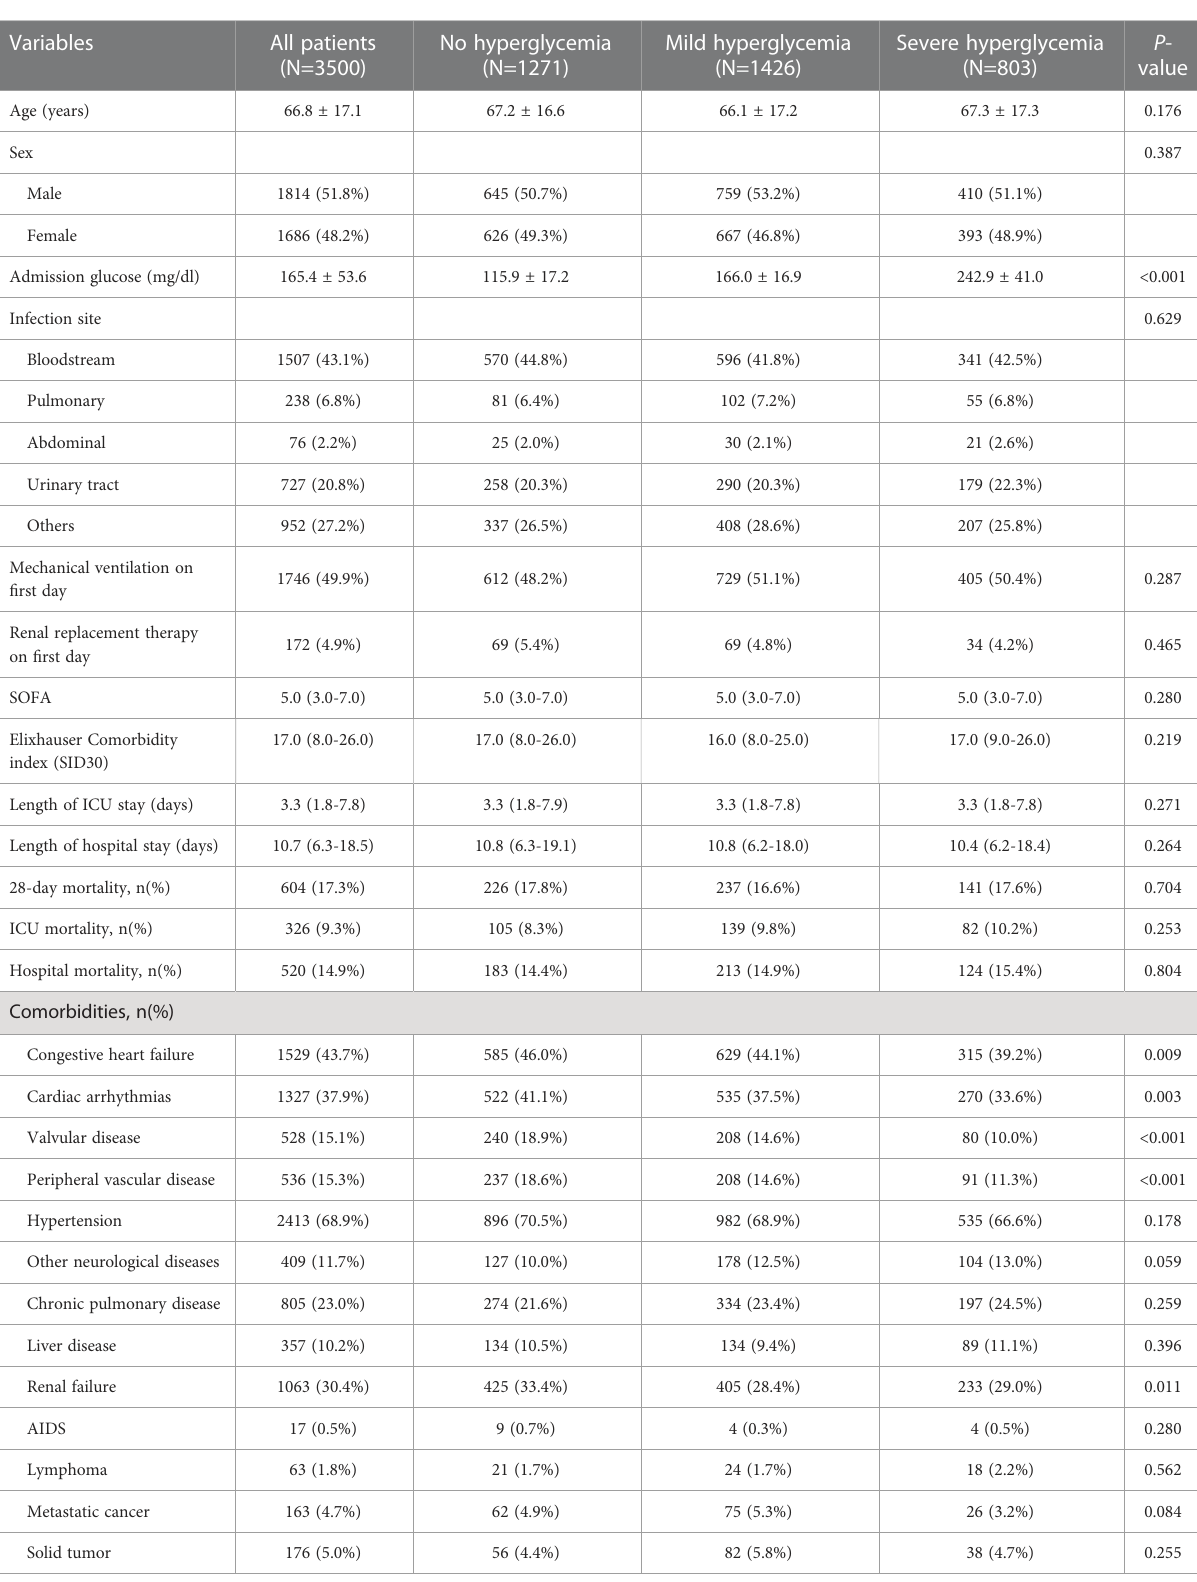
TABLE 1 Characteristics of